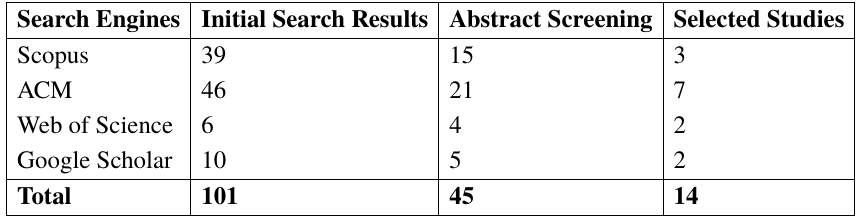
Table 1. Initial search results for data